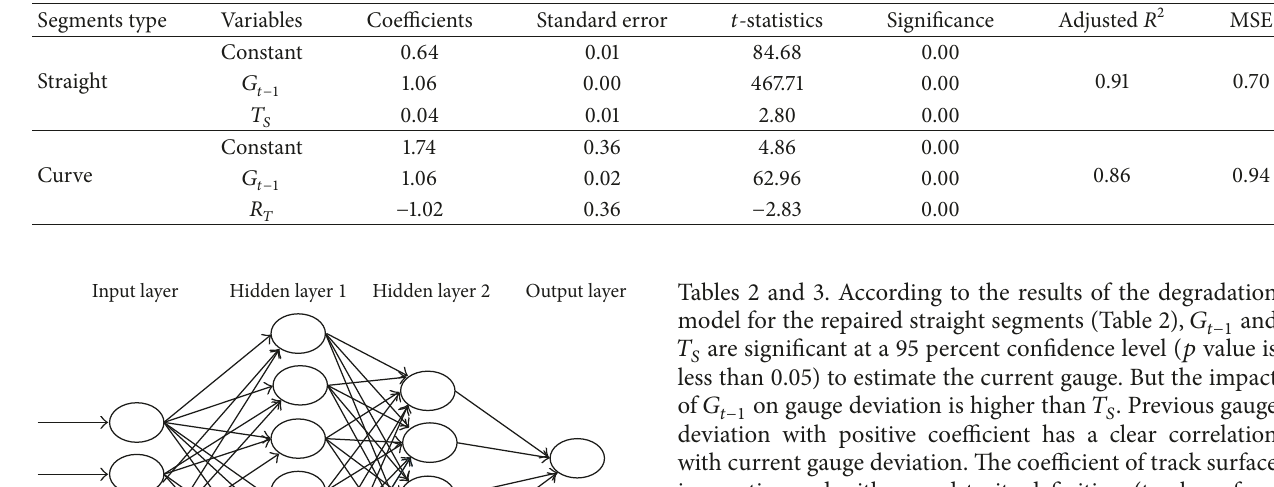
Table 3: Results of regression models for unrepaired segments.